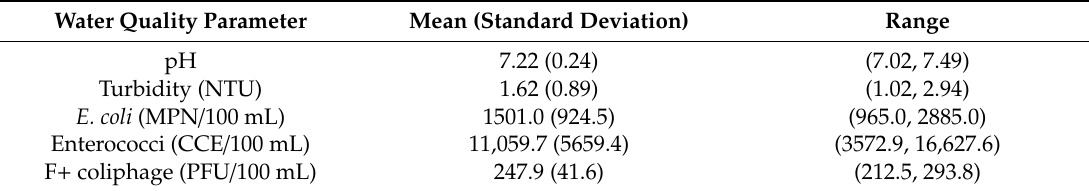
Table 2. Characteristics of diluted wastewater (100 L) prior to ozonation at UIC, at baseline. n = 4 trials, except for F + coliphage, which was measured in 3